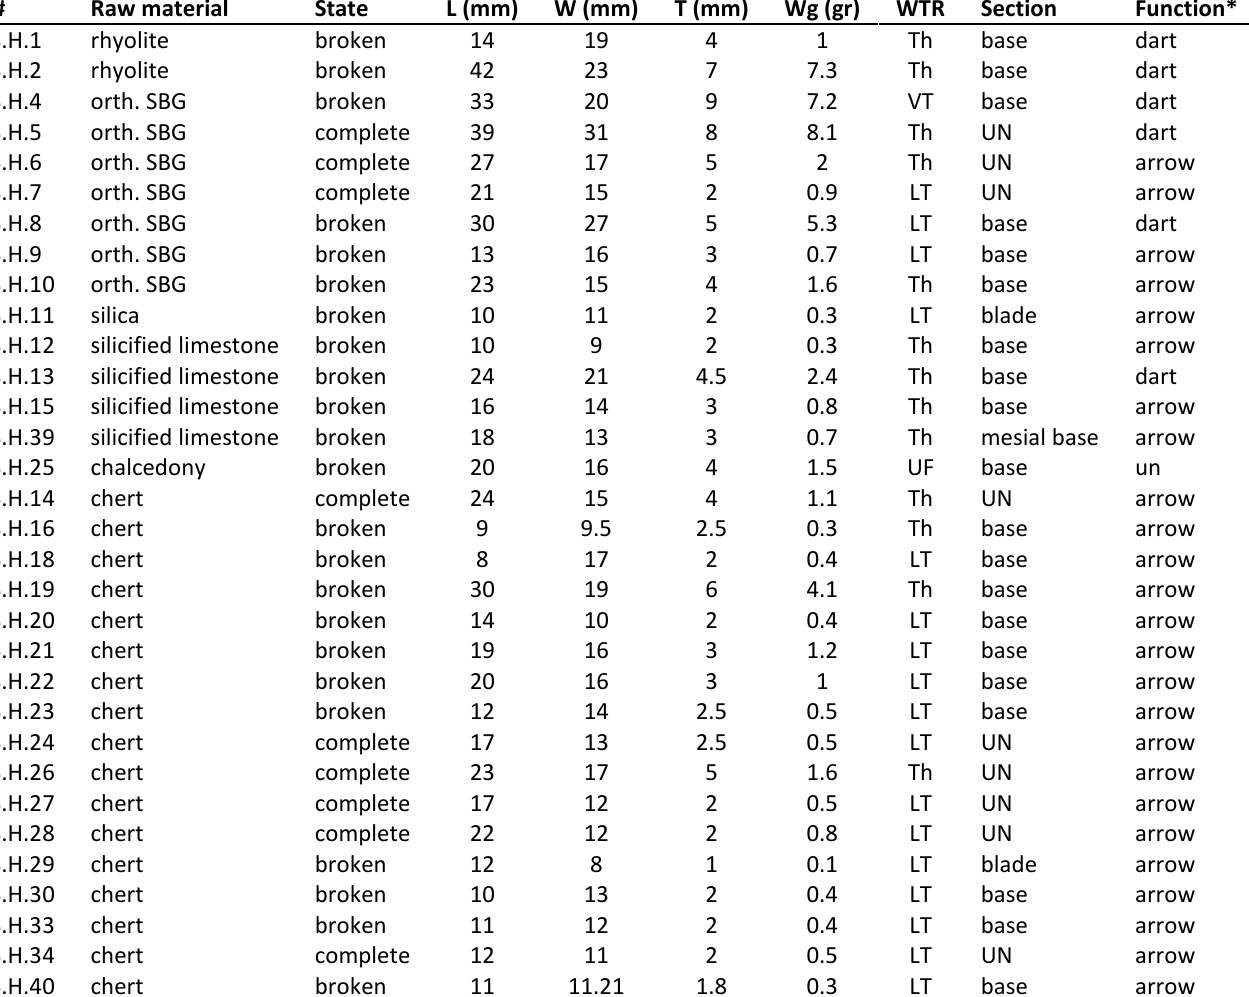
Table 5. Variables measured for the projectile points of Hangar. References: Orth = orthoquartzite; L = length; W = width; T = thickness; Wg = weight; WTR = width- thickness ratio; Th = thick; VT = very thick; LT = little thick; UF = undifferentiated because of the fracture; UN = undetermined; * = according to Shott (1997) equation. ID # Raw material State Section